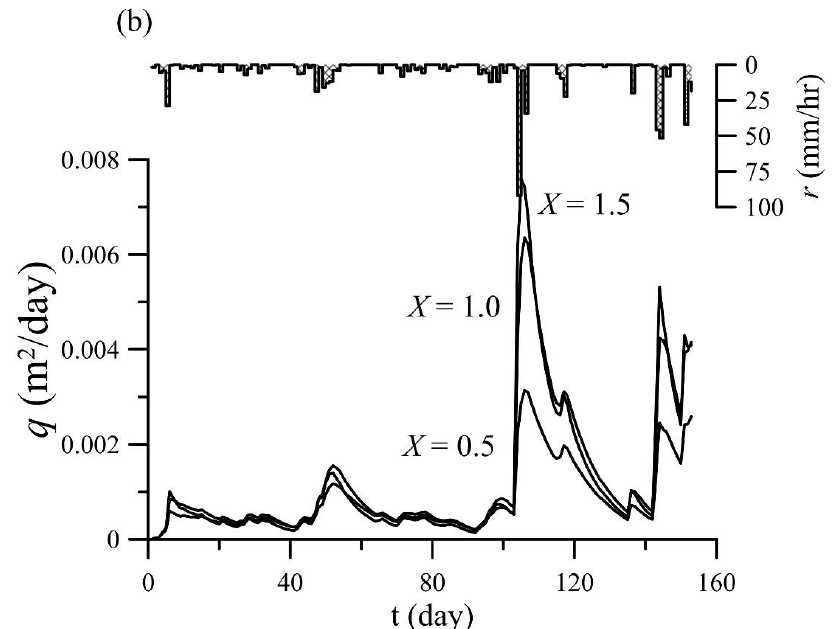
Figure 10. Variation of groundwater outflow due to the time-varying recharge rate at different locations in ( a ) 2012 ( 𝜀 = 0.3,ℎ 0 = 53.5 m,𝐷 = 80 m ) and ( b ) 2013 ( 𝜀 = 0.3,ℎ 0 = 54.0 m,𝐷 = 80 m ).